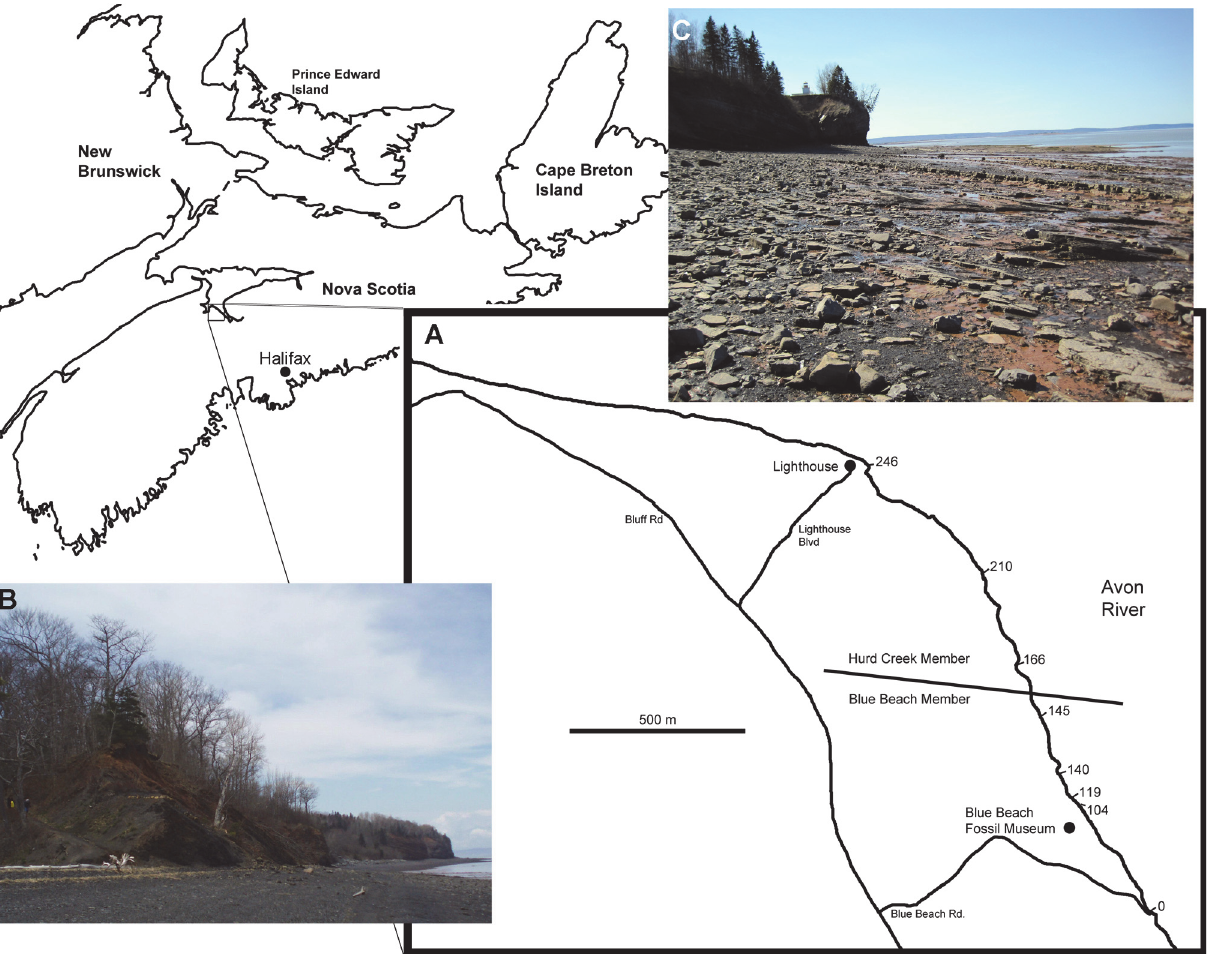
Fig 1. Location of Blue Beach. A, map of the shore line cliff along the Avon River Estuary where Horton Bluff Formation strata are exposed (continuing into the intertidal zone); B, Oldest beds (Hurd Creek Member) at the base of the section showing the road termination on the beach; C, the cliff and intertidal zone at Lighthouse Point (Blue Beach Member), where the majority of tetrapod specimens were